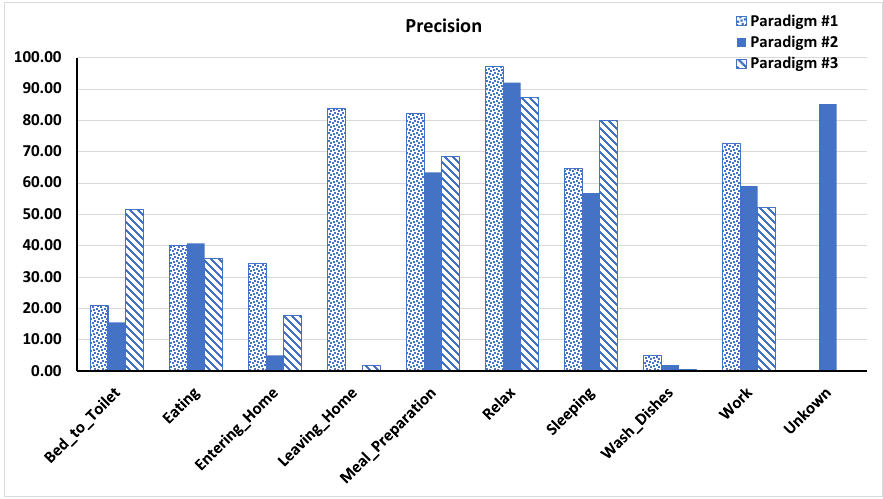
Figure 7. Precision evaluation of the proposed